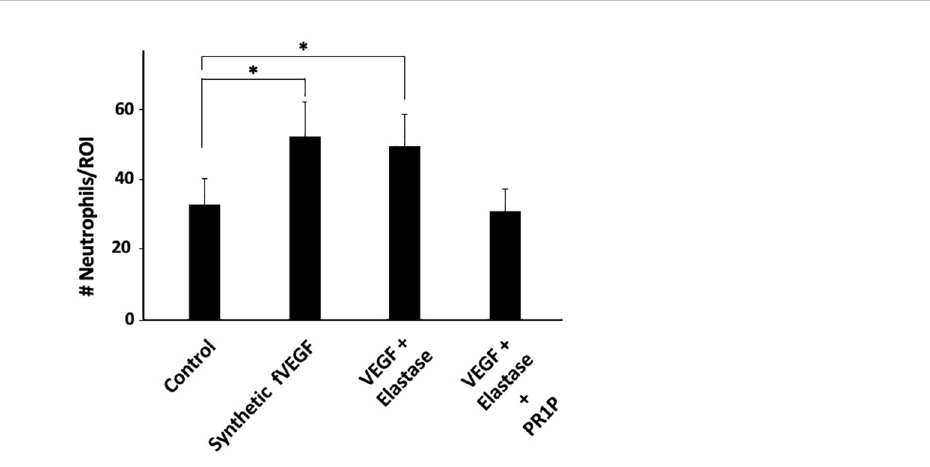
FIGURE 1 PR1P attenuates neutrophil migration in vitro by preventing VEGF degradation. Bar graph showing the quanti fi cation of neutrophils (# Neutrophils/ Region of Interest (ROI)) during Transwell Plate Migration assay in which neutrophil migration (2h) was in response to indicated stimulants. ‘ fVEGF ’ was commercially synthesized based on a published amino acid sequence (20). ‘ VEGF + Elastase ’ and ‘ VEGF + Elastase + PR1P ’ were products of 30 min incubation of VEGF and elastase in presence or absence of PR1P, respectively. (n=6 repeated 3 times). Data are mean +/- SEM.